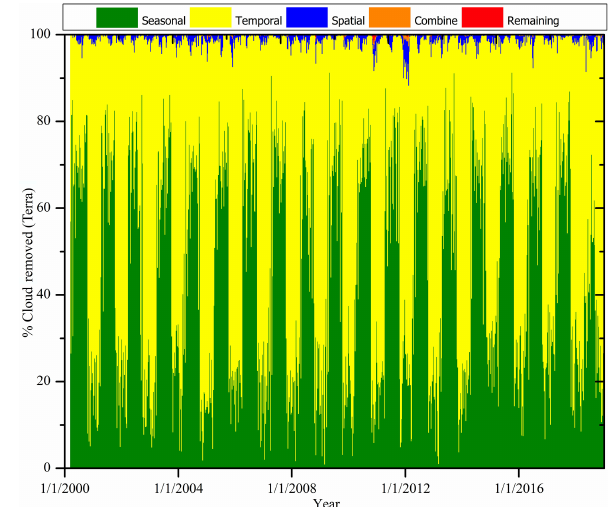
Figure 3. Spatial filter of the methodology describing cloudy pixels conversion to snow and no snow. If a majority of the surrounding pixels are snow or no snow, the cloudy pixels are assigned the same respective value.